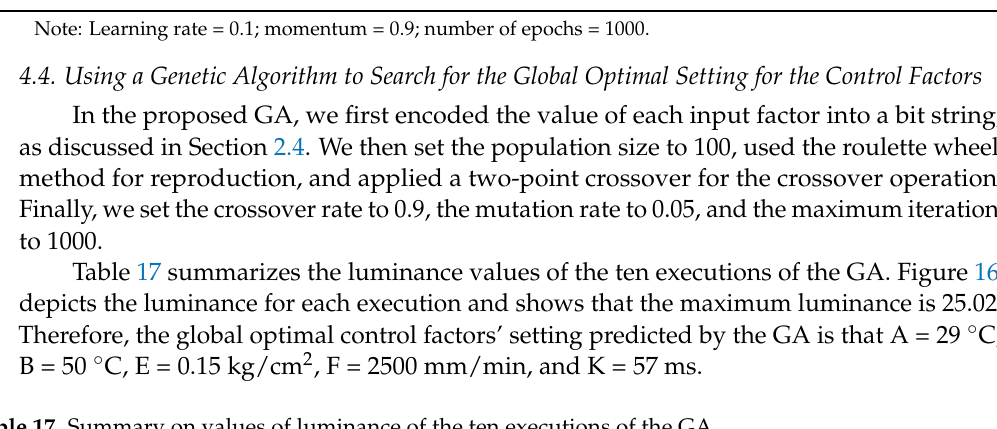
Table 17. Summary on values of luminance of the ten executions of the GA.